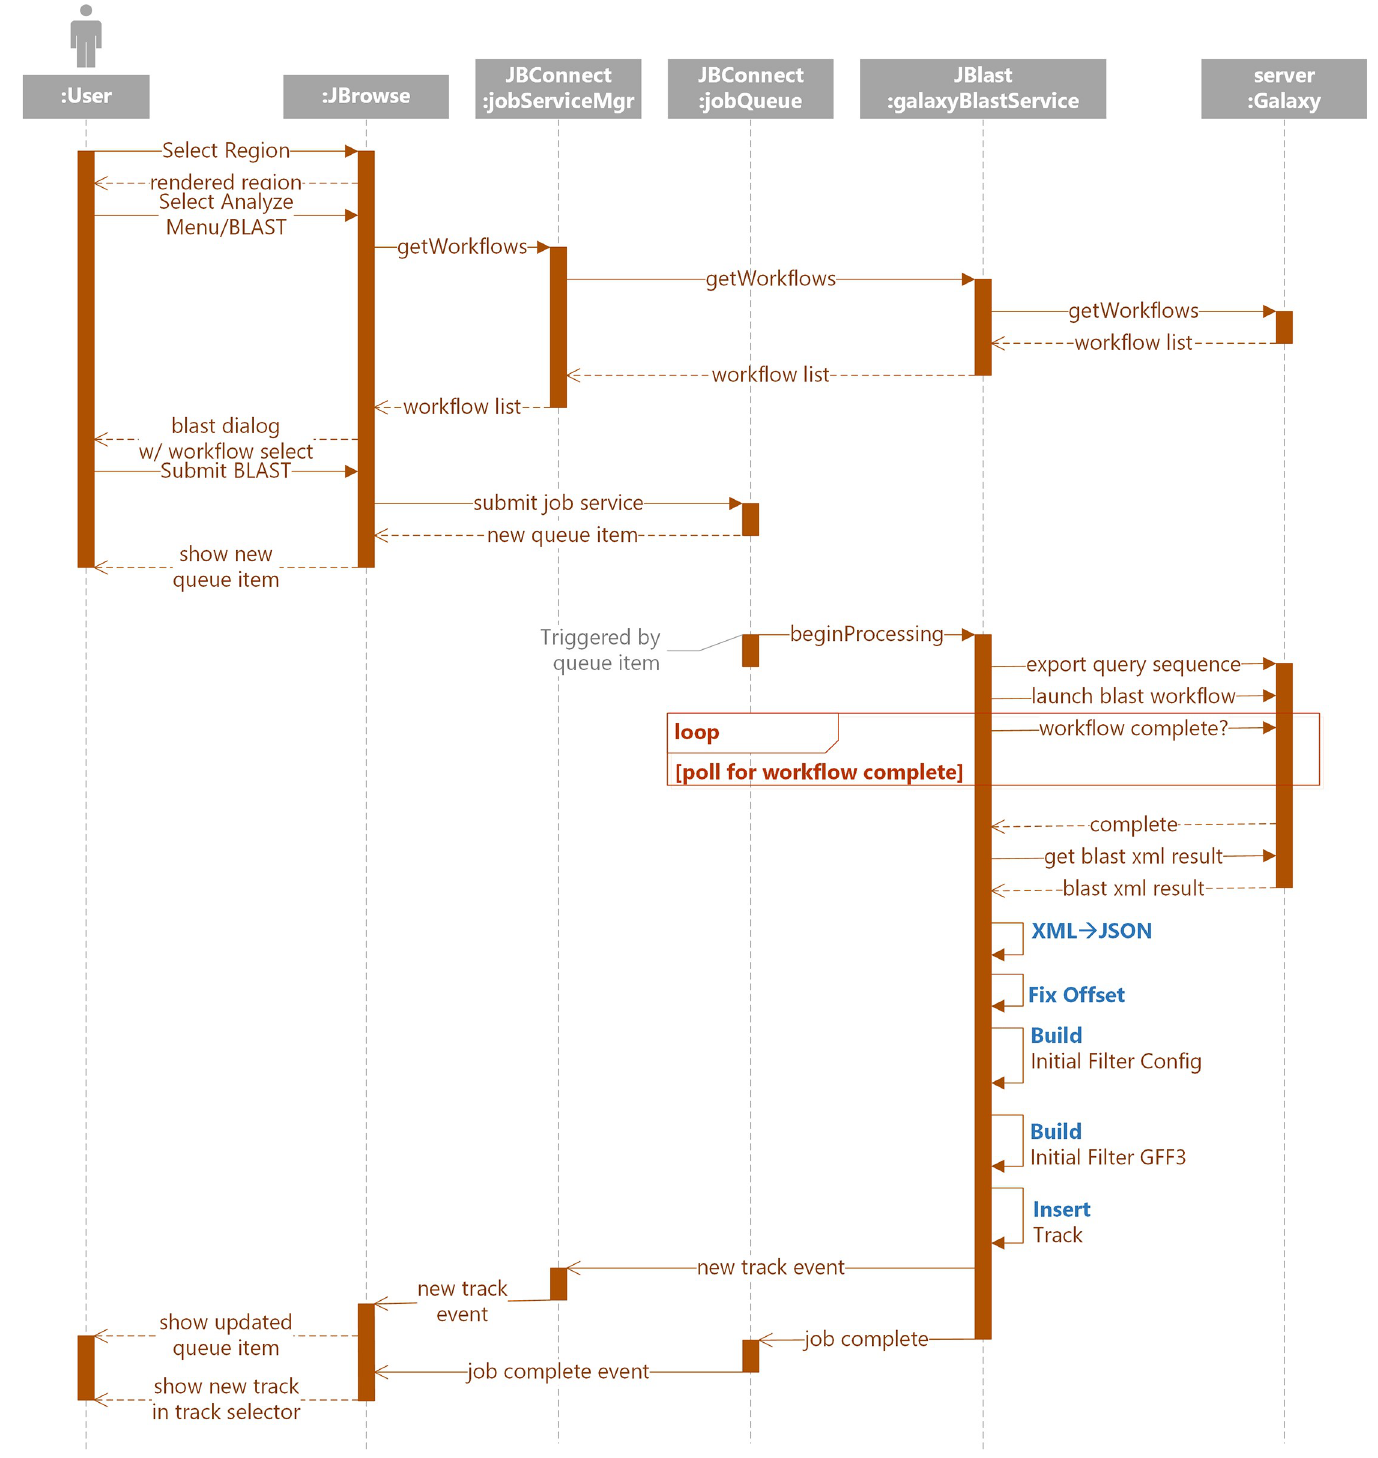
Fig 10. Running a BLAST job using the Galaxy back-end is similar to running BLAST as a standalone service from the user perspective, but involves the galaxyBlastService module that interfaces the Galaxy. galaxyBlastService pre-processes the data before sending it to Galaxy and post-processes the results of the Galaxy workflow